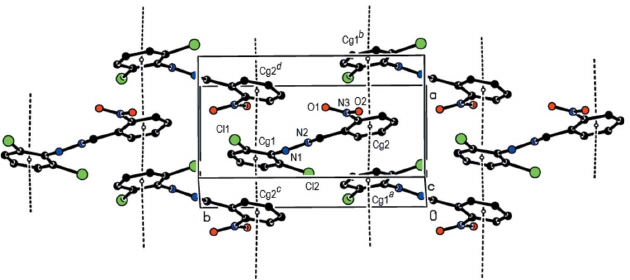
Figure 2 A view of (cid:2) – (cid:2) stacking interactions of in the crystal packing of the title compound. Cg 1 and Cg 2 are the centroids of the C1–C6 and C8–C13 benzene rings, respectively. [Symmetry codes: ( a ) 1